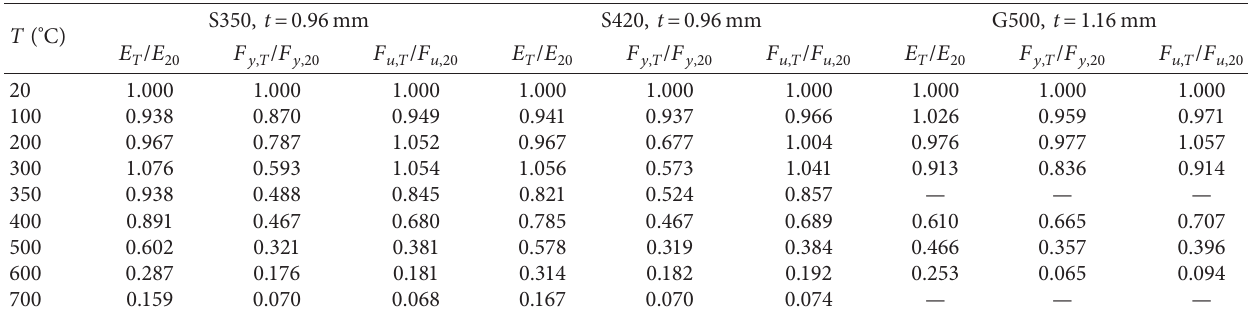
Table 6: Retention factors for the elastic modulus, yield strength, and ultimate